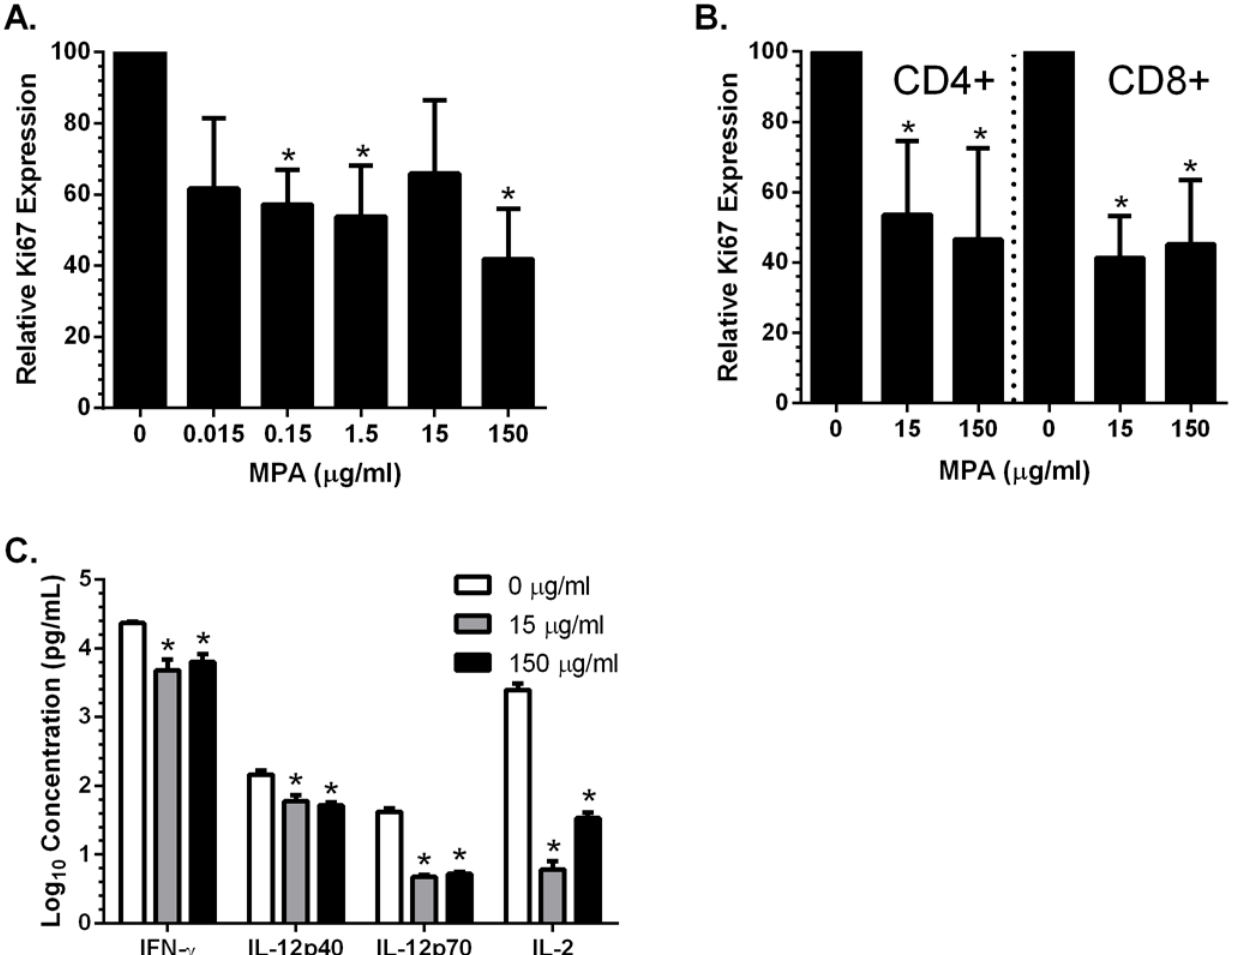
Fig 4. MPA decreases cell proliferation and PBMC response to activation. VK2/E6E7 cells were plated in the presence or absence of the indicated concentrations of MPA and after 5 days in culture, the cells were trypsinized and stained for Ki67 expression by flow cytometry analysis (A). PBMC were isolated and treated with PHA and the indicated concentrations of MPA for 3 days and analyzed by flow cytometry (B). Data is expressed as Ki67 + expression in live epithelial (A) and live CD4+ or CD8+ T cell populations (B) relative to mock-treated cells. Results are mean + SEM of three independent experiments (A,B). PBMC were plated in the presence or absence of MPA. At 3 days post-treatment, PBMC were activated with PHA (5 μ g/ml) and incubated for an additional 3 days. Supernatants were collected and analyzed for cytokines and chemokines (C). Results are mean + SEM obtained from two different blood donors (C). Asterisks indicate statistically significantly different from mock-treated cells, p < 0.05, Student ’ s